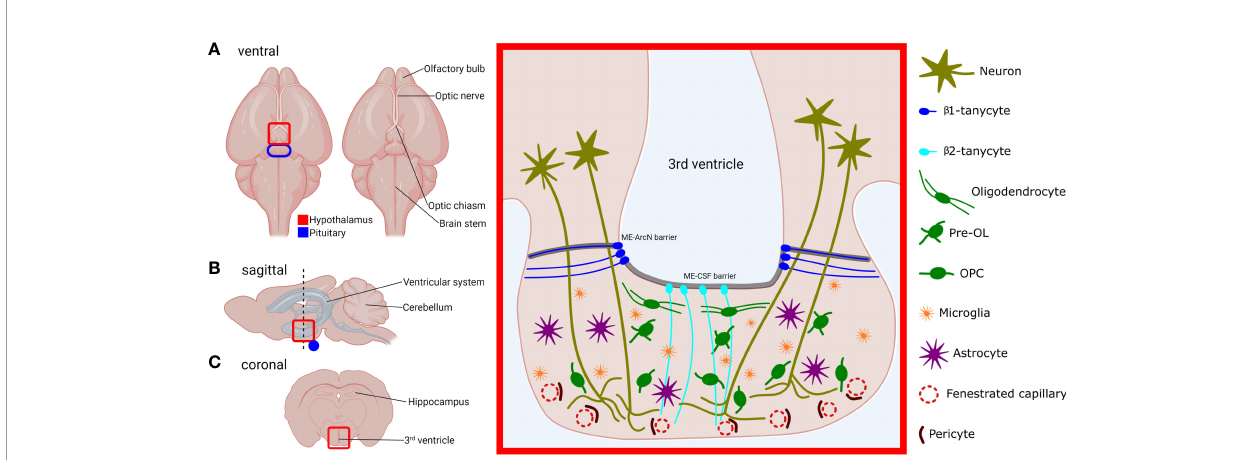
FIGURE 1 | Location, structure and cell types of the murine median eminence (ME). Locations of the hypothalamus (red) and pituitary (blue) are outlined, in the ventral (A) , sagittal (B) and coronal view (C) . Red-boxed area on the left represents the red-highlighted area in the coronal plane (C) , and shows the structure of the ME and its constituent cell types. OL, oligodendrocyte; OPC, oligodendrocyte precursor cell. Neurohormone-producing neurons project from the hypothalamus and abrogate in the ventral portion of the ME which contains fenestrated capillaries. Secreted hormones are then carried through the portal vasculature to the anterior pituitary gland. The 3 rd ventricle at the ME is lined with tanycytes. b 1-tanycytes project laterally and are thought to isolate the ME milieu from the rest of the hypothalamus. b 2-tanycytes project ventrally and junctions between their cell bodies prevent diffusion of substances from the ME to the CSF and vice versa. Myelinating oligodendrocytes are predominantly found in the dorsal section of the ME, which contains axons that project to the posterior pituitary. OPCs, microglia, and astrocytes are found throughout the ME body.